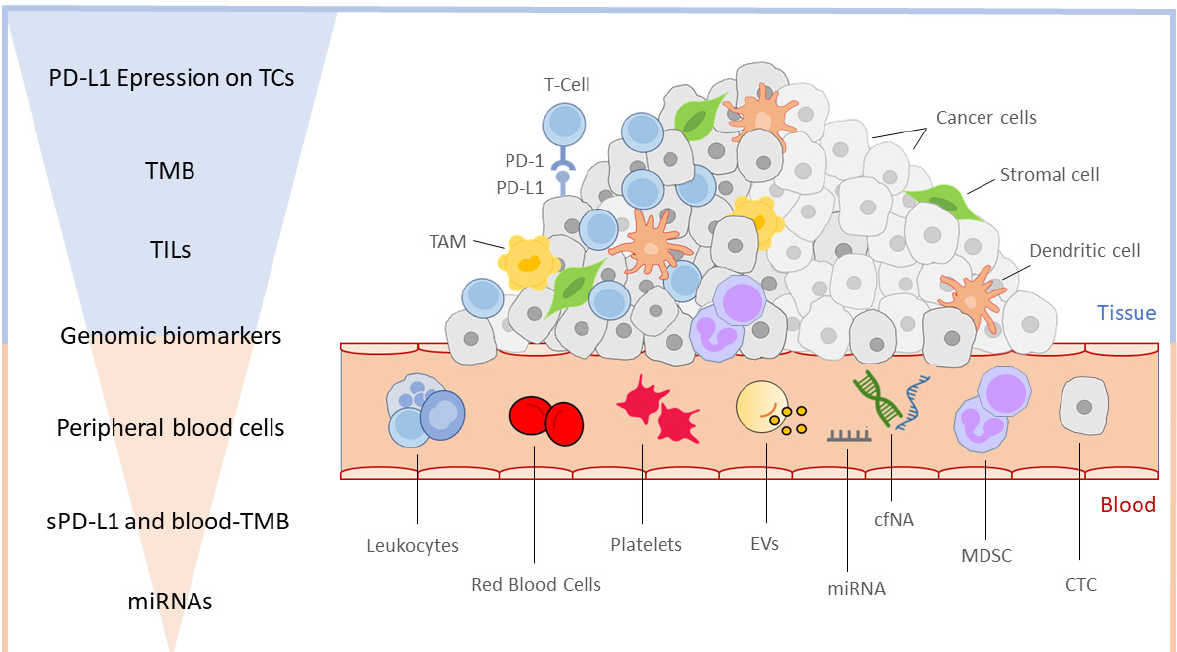
Figure 1. Tissue- and blood-derived biomarkers for ICIs in NSCLC. The figure shows biomarkers detectable using tissue and blood biopsies. On the left side, the biomarkers are listed in descending order, first the tissue and then the blood ones, according to the amount of evidence and robustness of the literature data. PD-L1 expression on tumor cells remains the main biomarker, currently the only one validated in clinical practice. Genomic biomarkers including MSI and other aberrations lie in the middle position because they are findable by both tissue and liquid biopsy. On the right side, the tumor microenvironment is represented. The cancer mass differs in a cold tumor and hot tumor, the latter characterized by a higher density of tumor-infiltrating lymphocytes (TILs) and other immune cells, such as tumor-associated macrophages (TAMs). Many cell populations from TME, including immune cells and circulating tumor cells (CTCs), flow into the bloodstream and can be analyzed through liquid biopsy. Promising data on biomarkers research comes from cell-free nucleic acids (cfNA), especially microRNAs (miRNA) derived from extracellular vesicles (EVs), especially exosomes.